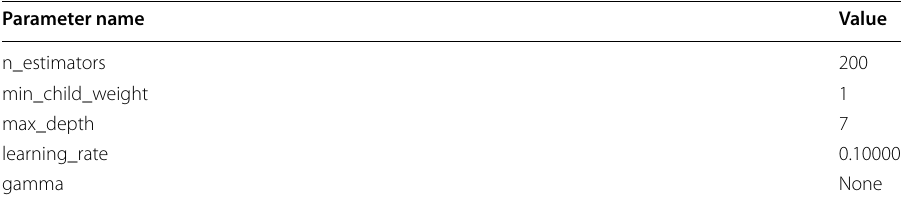
Table 103 Modes of XGBoost tuned hyperparameter values for experiments with the keylogging dataset